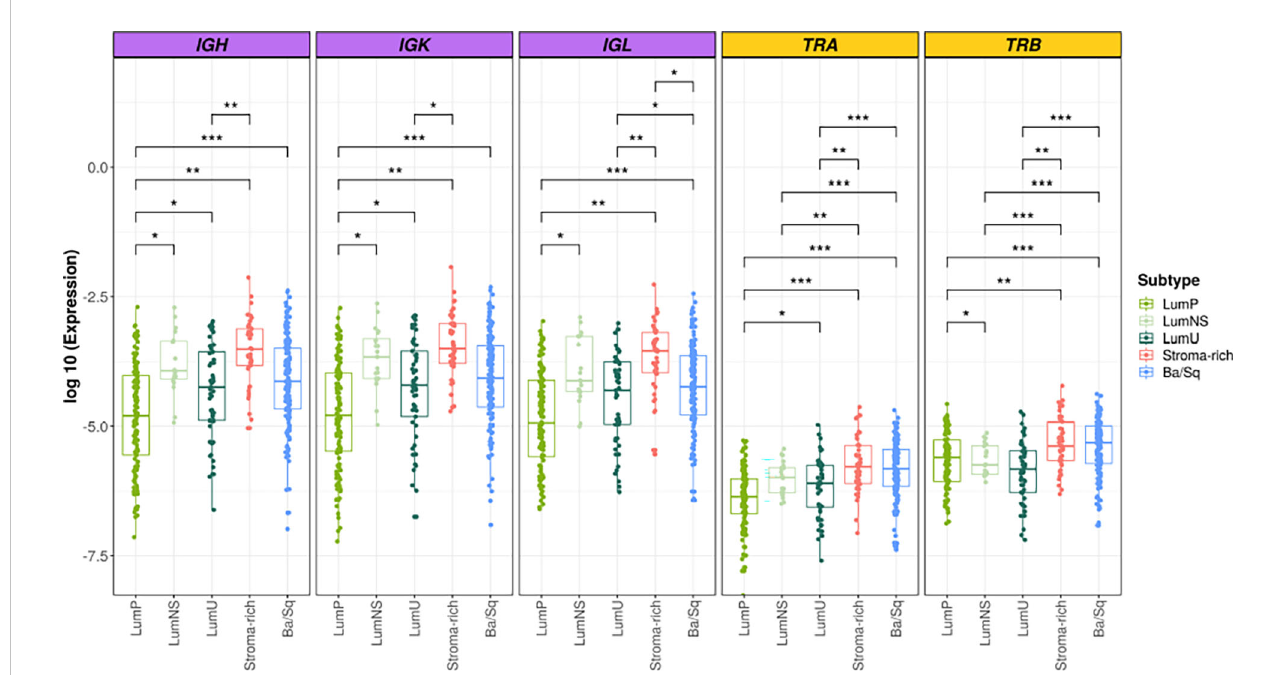
FIGURE 1 BCR and TCR richness among the different MIBC subtypes. BCR related results are plotted in purple and TCR in yellow. In the Y axis the logarithm of the expression is represented. Each box of the boxplots is a subtype (see legend). The differences between richness across the subtypes are displayed only when signi fi cant. * → 0.05 > p > 0.01; ** → 0.01 > p > 0.001; *** → p <